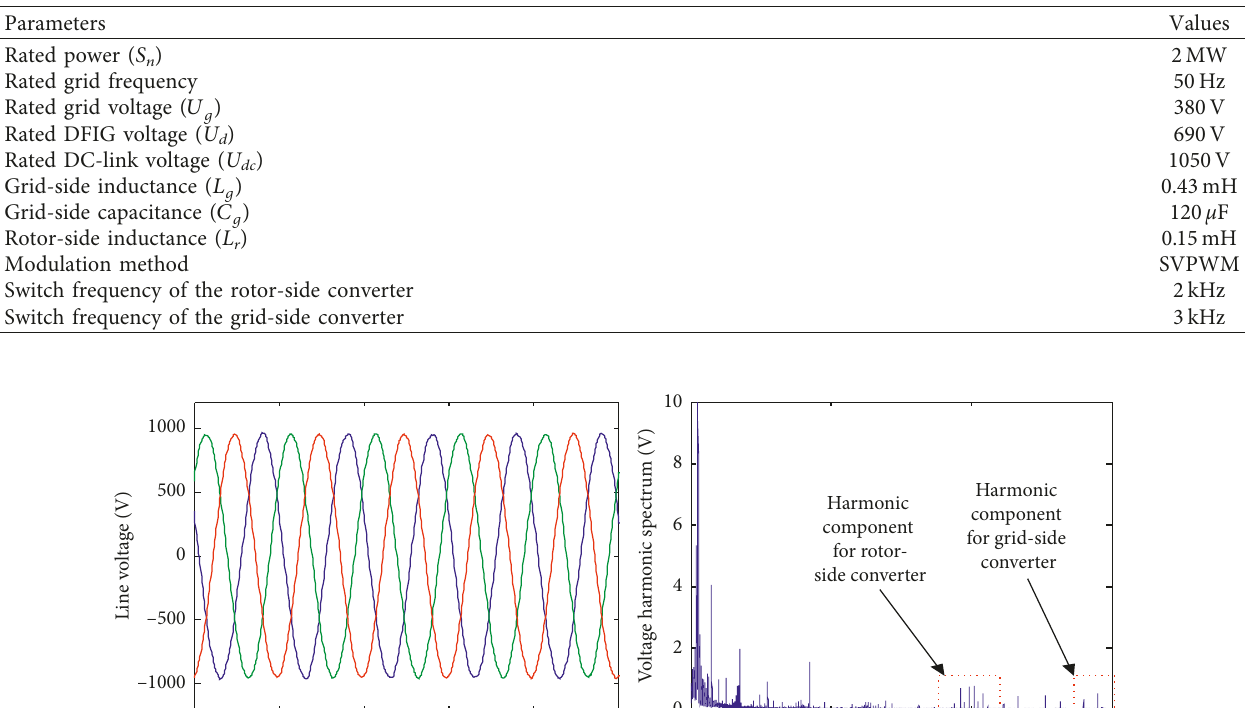
Table 2: Detailed parameters of the DFIG test platform.